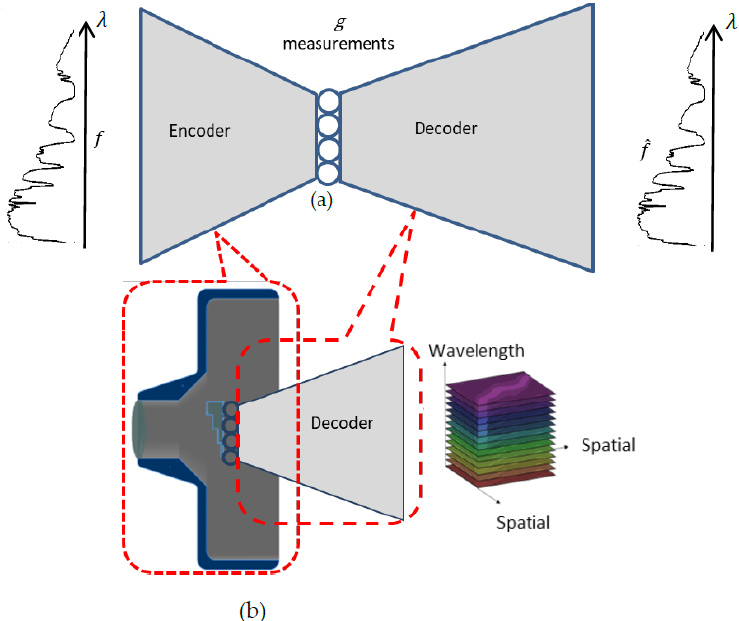
Figure 2. ( a ) DNN encoder, which models our SpLM, is used to optimize the gaps of the mFPR stair-shaped etalons by learning from pairs of inputs f and the labels ˆ f . The outputs of the encoder, g , at the bottleneck of the autoencoder, represent the measurements. ( b ) After the optimal gaps of the mFPR’s stair-shaped etalons are learned by the encoder, the staircase-shaped SpLM can be produced and replace the software encoder.